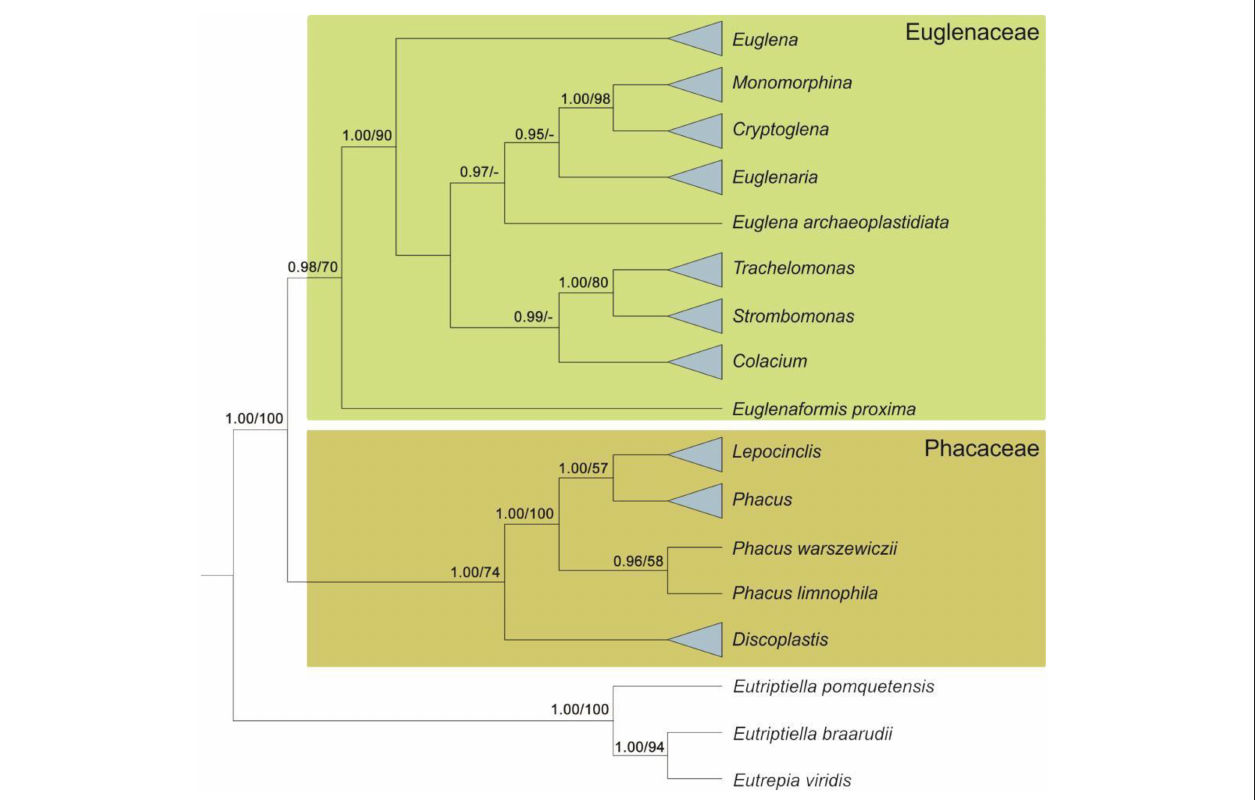
FIGURE 3 | Diagram of a Bayesian tree for the phototrophic euglenids based on mutigenes (nSSU, nLSU, cpSSU, hsp90, and psbO). Numbers at internal nodes represent posterior probability (pp) values followed by bootstrap support (bs) values. Support values below 0.75 pp and below 50 for bs are marked with dashes (adapted from Karnkowska et al.,